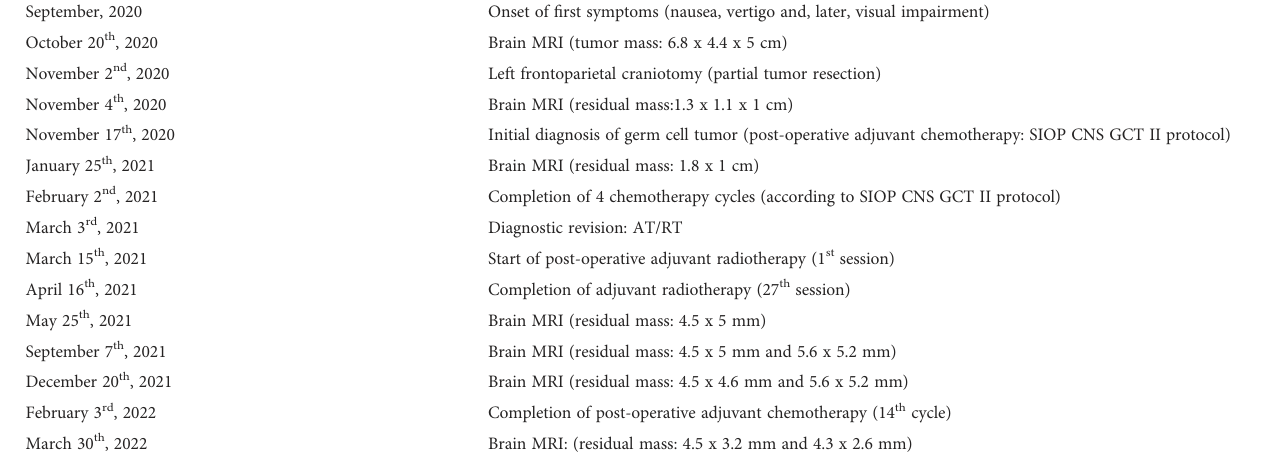
TABLE 1 Timeline of the clinical episode.